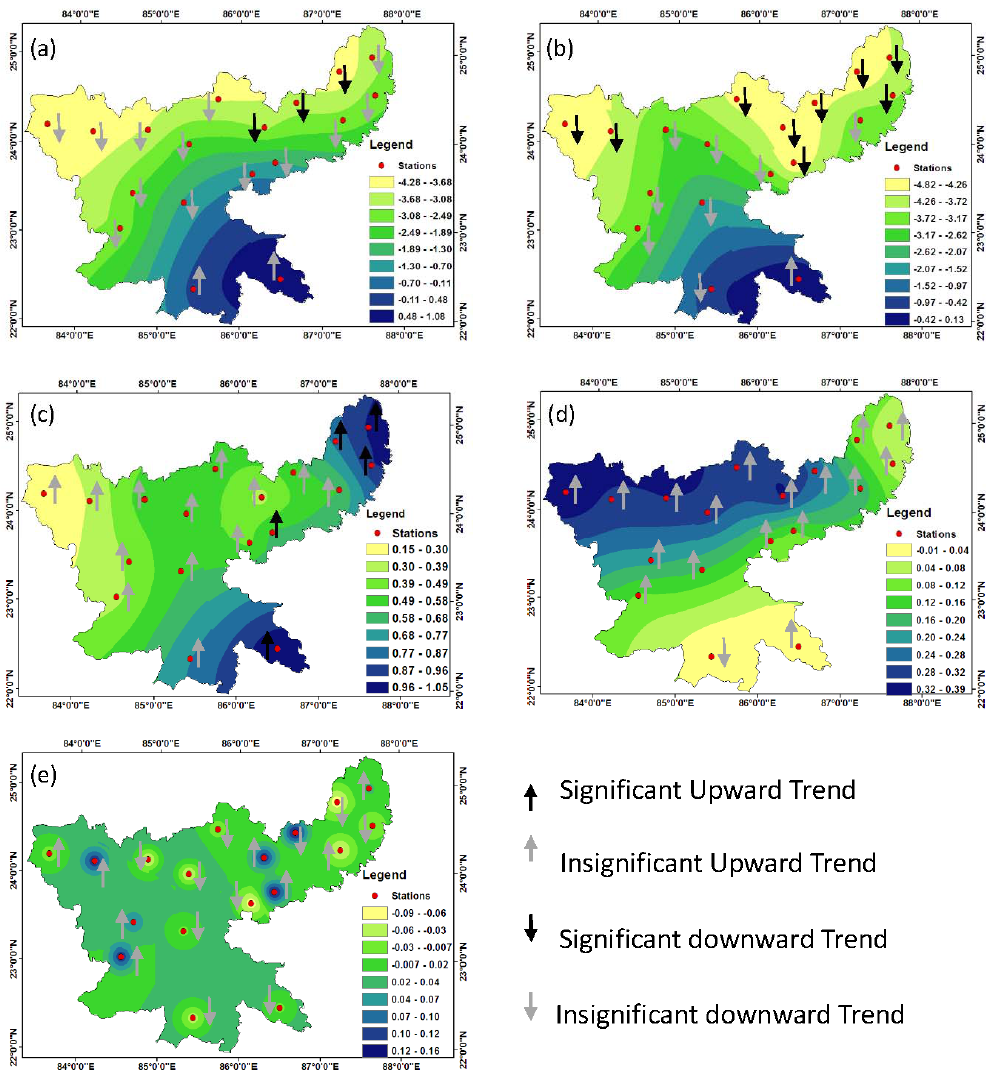
Figure 6. Spatial distribution of Sen’s slope value and trend direction (Mann Kendall statistics) from 1952–2002 of ( a ) Annual; ( b ) Monsoon; ( c ) Pre-monsoon; ( d ) Post-monsoon and ( e ) Winter season. Table 4. Percent change of Annual and Seasonal rainfall (1901–1951).